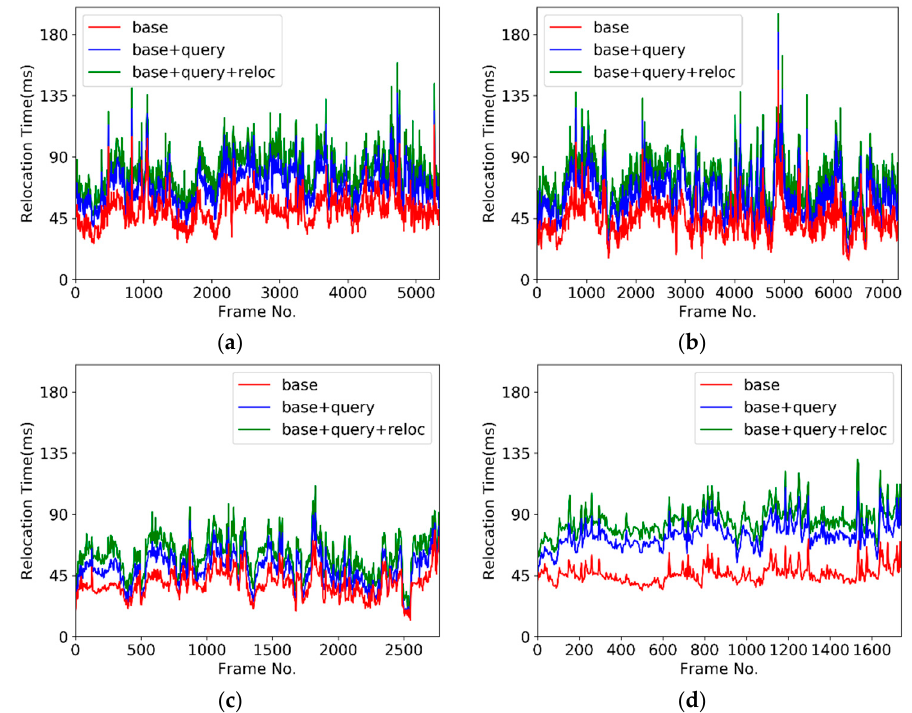
Figure 3. Relocation time cost in the offline experiment: ( a ) relocation time of model, ( b ) relocation of small items, ( c ) relocation time of ceramic horse, and ( d ) relocation time of emboss.